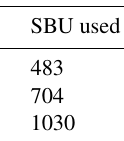
Table 2. System Billing Unit (SBU) consumption of a 24h fore- cast at T L 511L60. SBU is a unit of CPU consumption used at the ECMWF; its precise definition can be found at https://confluence. ecmwf.int/display/UDOC/HPC+accounting (last access: 3 Septem- ber